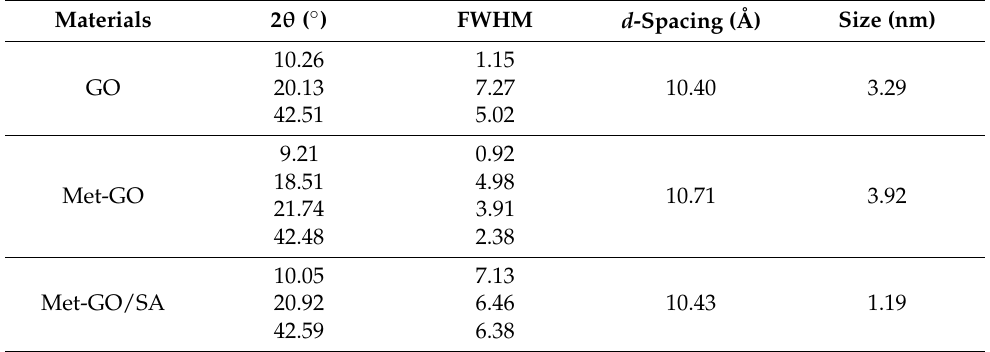
Table 2. Average crystallite size of GO, Met-GO and Met-GO/SA calculated using Debye-Scherrer formula.